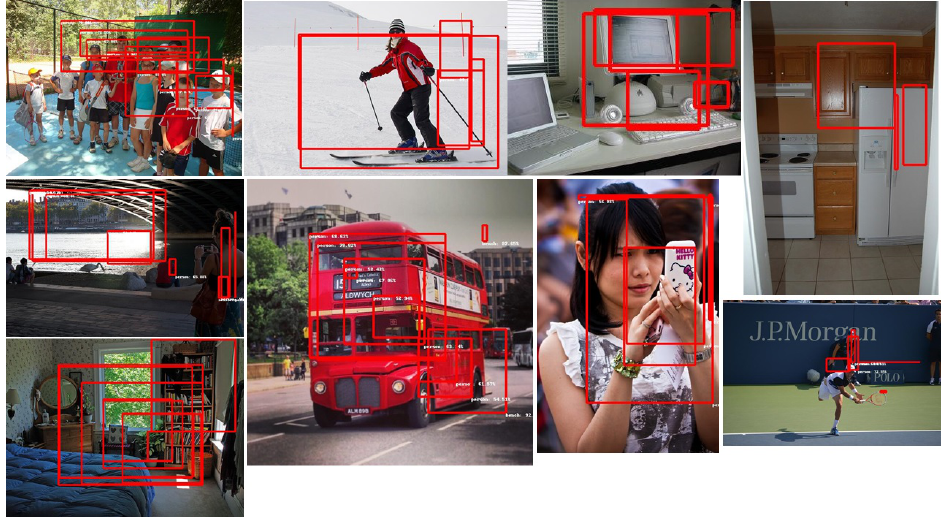
Figure 11. Bad inference results. Neither object location squares nor object class labels are